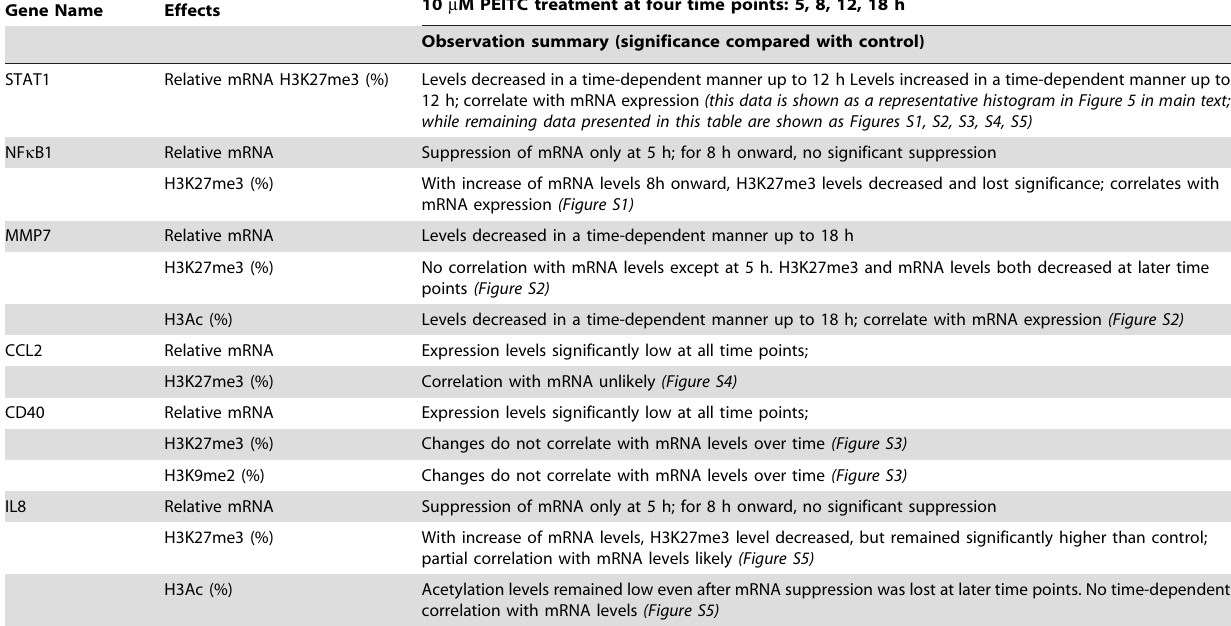
Table 4. Time-dependent correlation between mRNA expression and H3